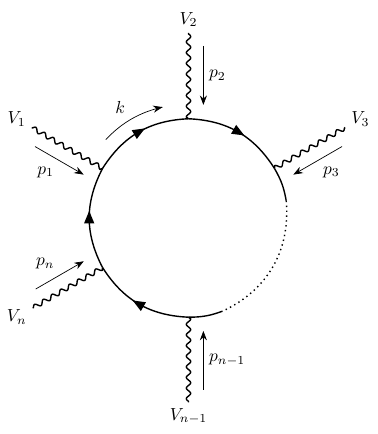
Figure 3 . Chiral loop with multiple vector insertions. Here we use the compact notation k ≡ ( ω,~k ) and p (Ω ) , i ∈ { 1 , . . . , n } i ≡ i , ~p i